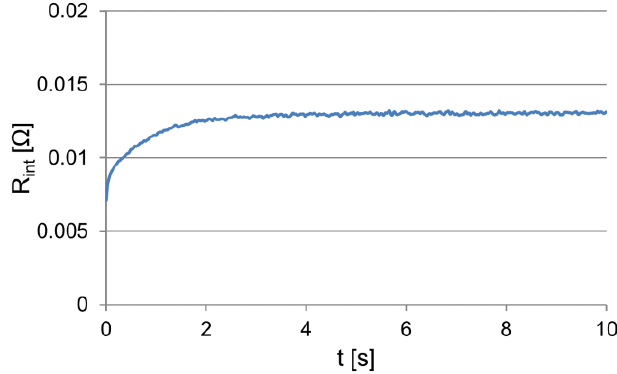
Figure 5. The changes in the internal resistance of the loaded battery.